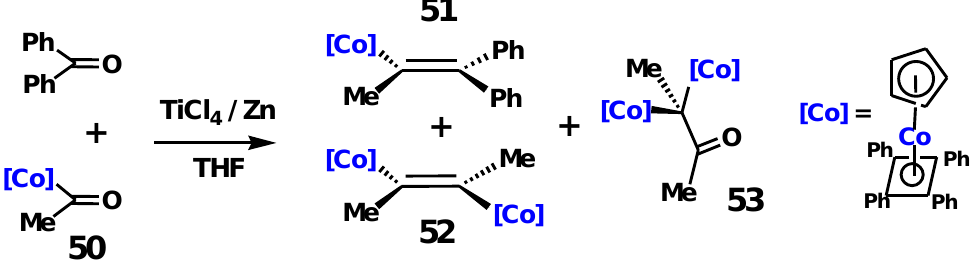
Scheme 14. Experimentally observed products derived from the McMurry reaction of [(η 5 -MeC(=O)C 5 H 4 )Co(η 4 -C 4 Ph 4 )] with benzophenone.